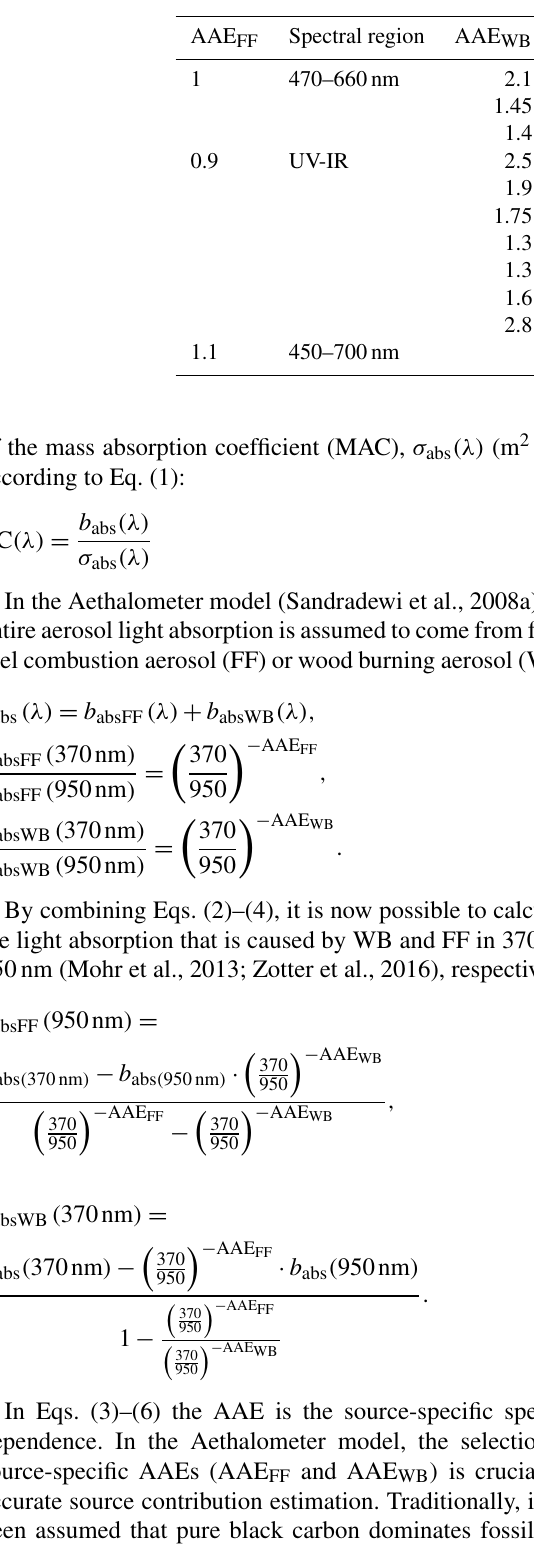
Table 1. Values of AAE FF and AAE WB derived from reference emission